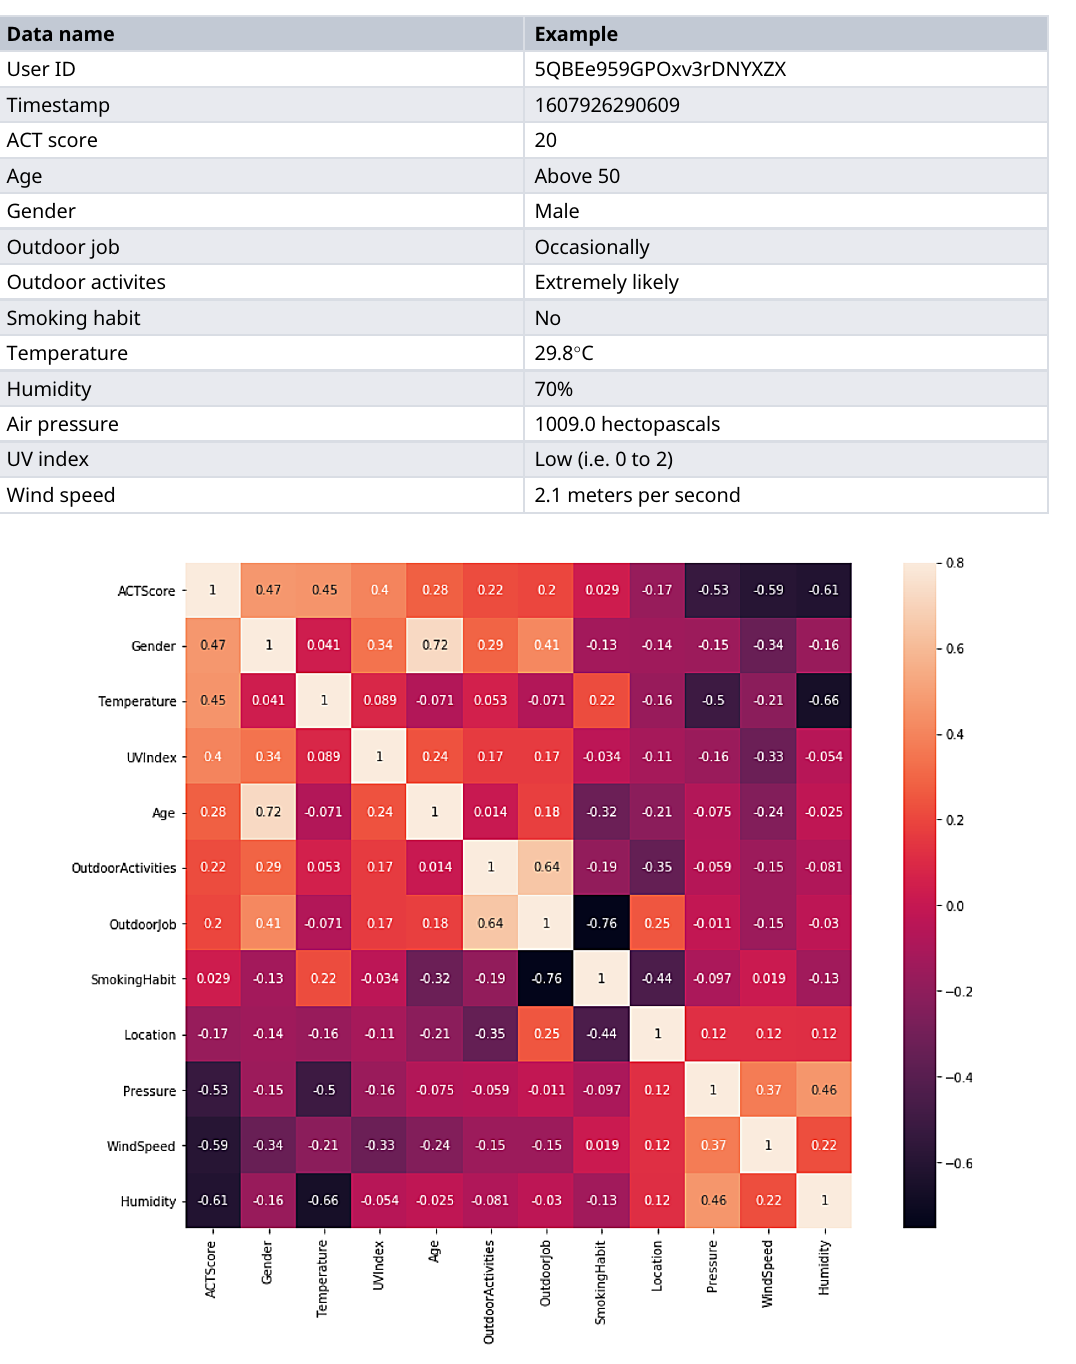
Table 1. Data collection example.